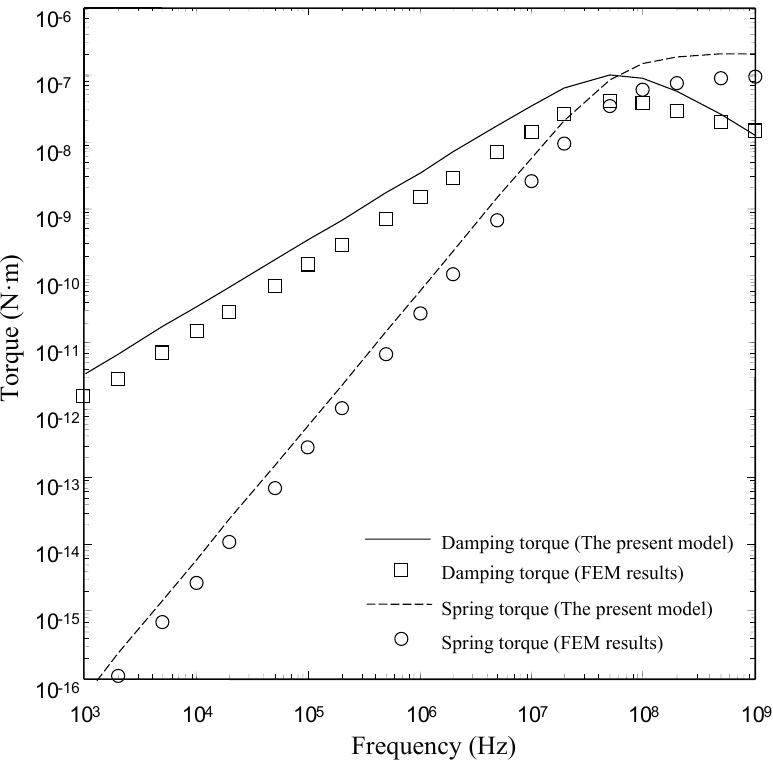
Figure 10. Comparison of the damping torques and the spring torques for microplate ( l h / l p = 0.7) obtained by the FEM model and the present model as a function of